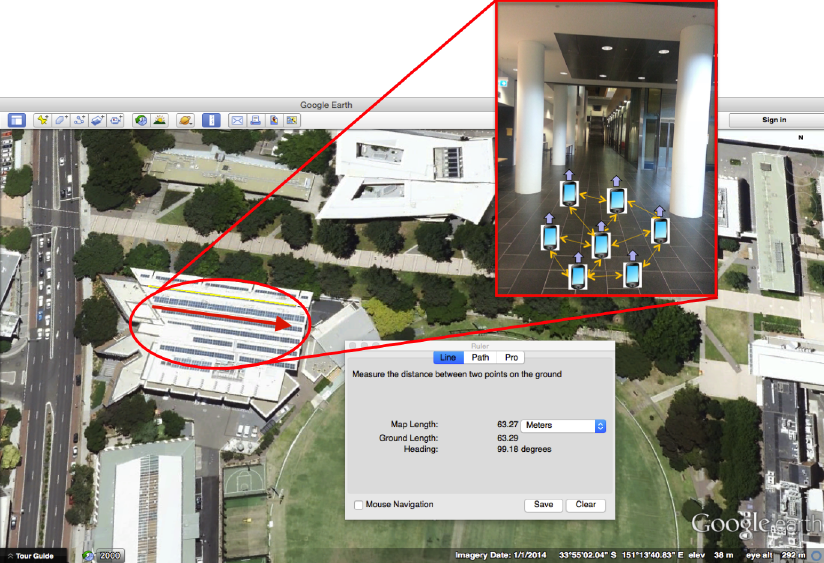
Figure 3. An indoor localization scenario with multiple pedestrians walking in the same direction along a corridor. Each smart phone in the figure denotes a pedestrian, while the edges connecting the devices indicate D2D connections between users sharing the heading. The figure also shows the satellite image (obtained from Google Earth) of the Tyree Buildings at the University of New South Wales, which was one of the building utilized in the experimental